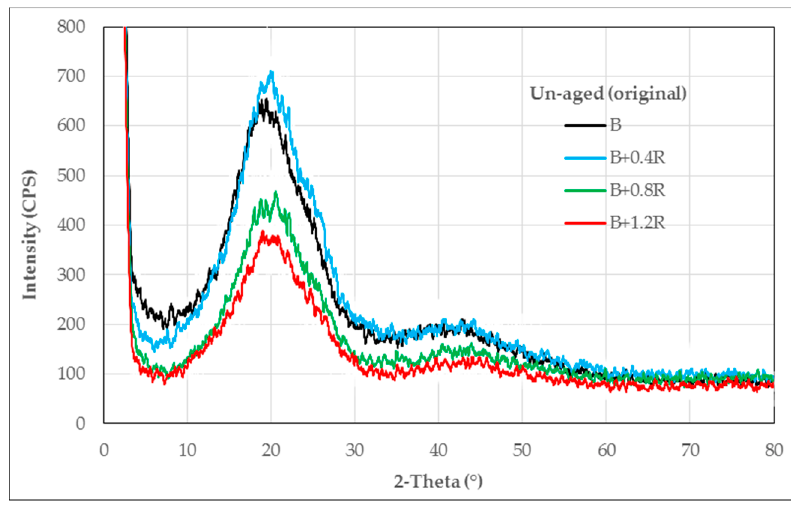
Figure 3. XRD patterns of the neat and Elvaloy®RET-modified bitumens.